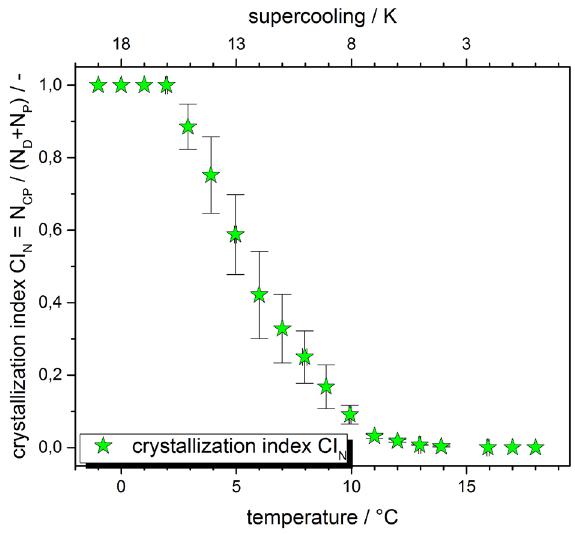
Figure 7. Number based crystallization index CI N as function of temperature and supercooling of 1 wt % hexadecane in Milli-Q water emulsions stabilized with 1 wt % Tween ® 20.